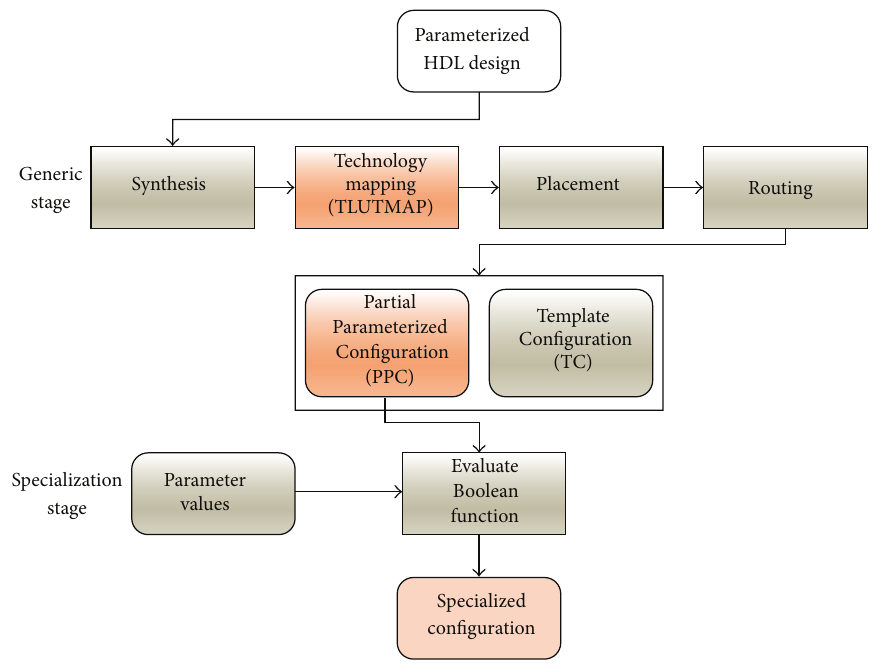
Figure 1: Dynamic Circuit Specialization tool flow (TLUT tool